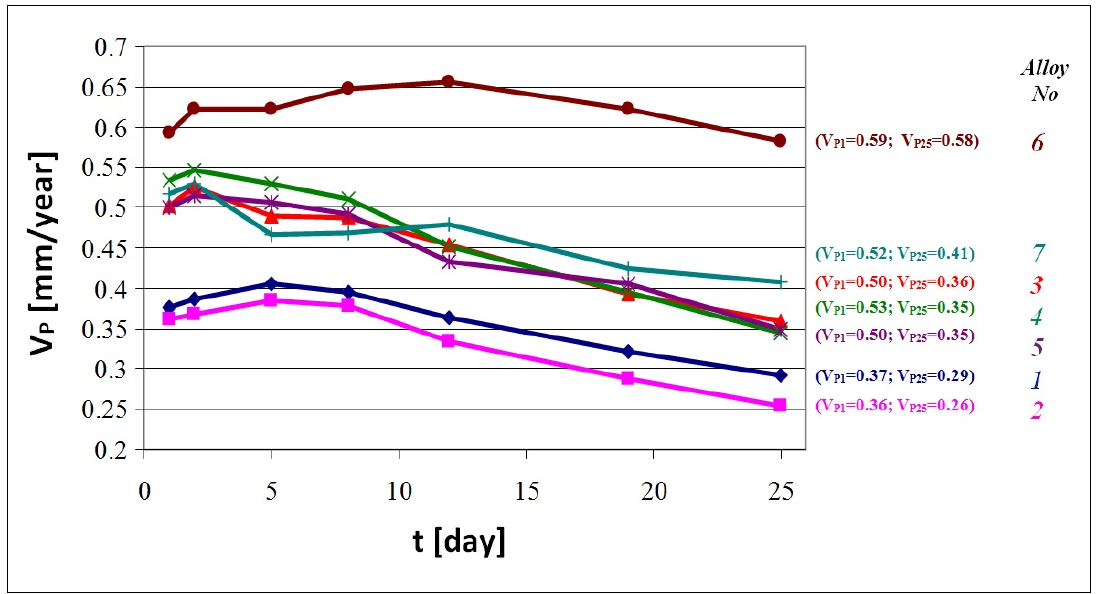
Figure 4. Average corrosion rate (V P ) (mm/year) of the alloys 1 to 7 in time: V P1 —corrosion rate after 1 day, V P25 —corrosion rate after 25 days.